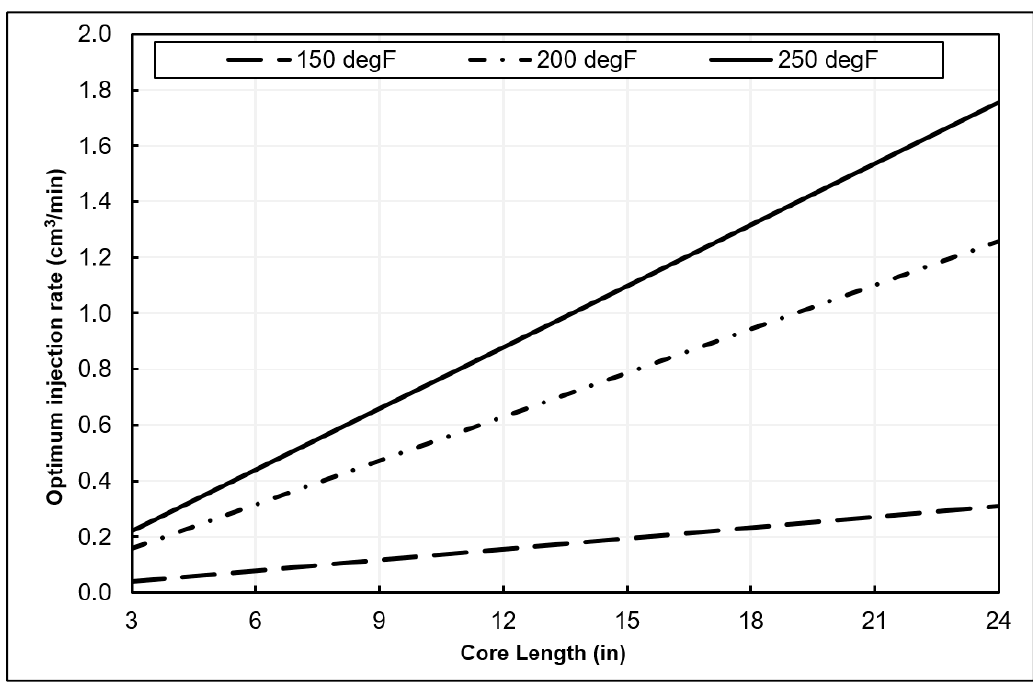
Figure 19. The optimum injection rate of 20 wt% GLDA/SW at pH 3.8 as a function of temperature and core length.